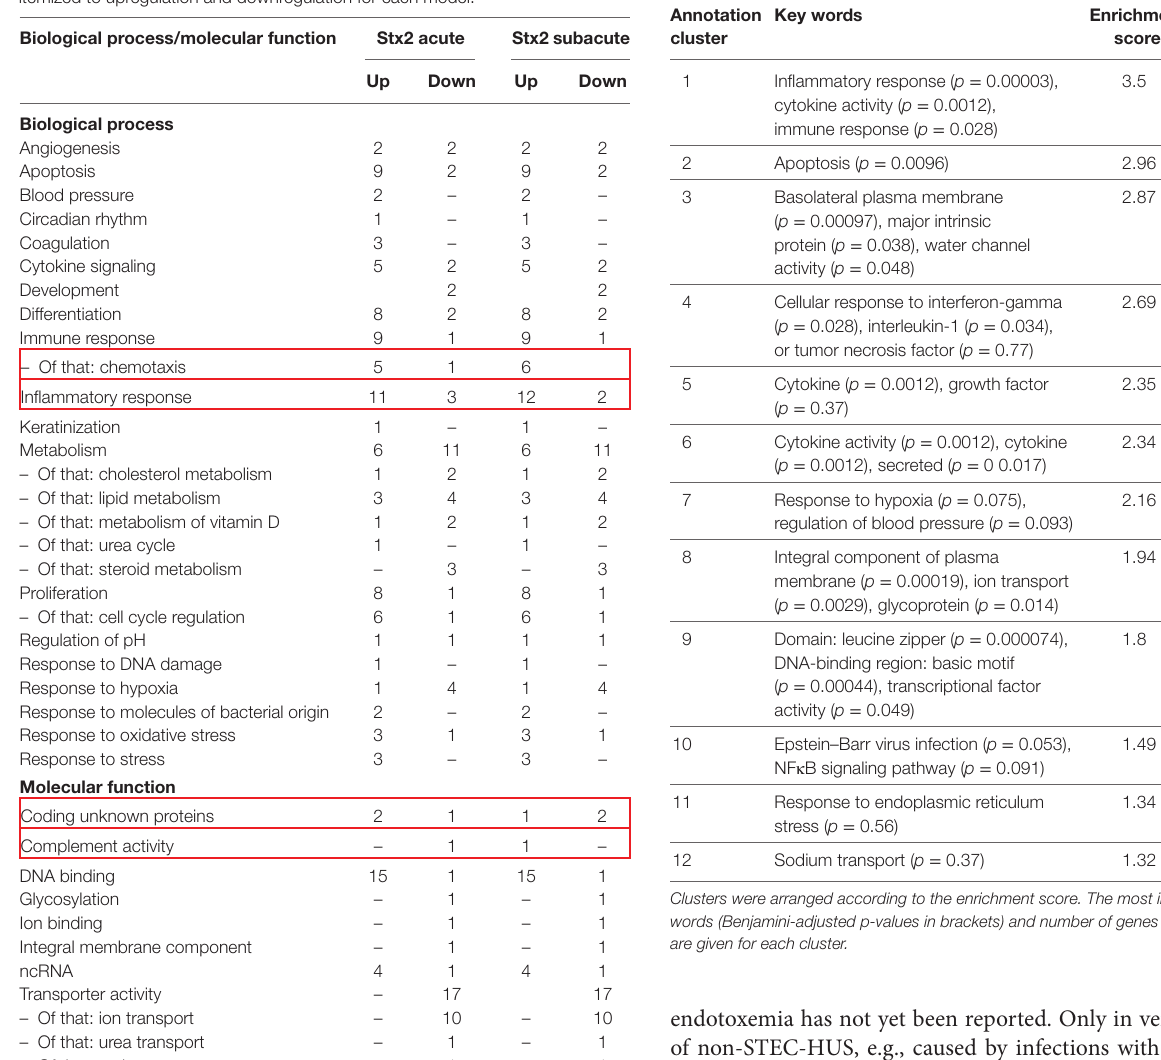
TaBle 1 | The 91 overlapping differentially expressed genes of the acute and subacute model were assigned to biological process or molecular function and itemized to upregulation and downregulation for each